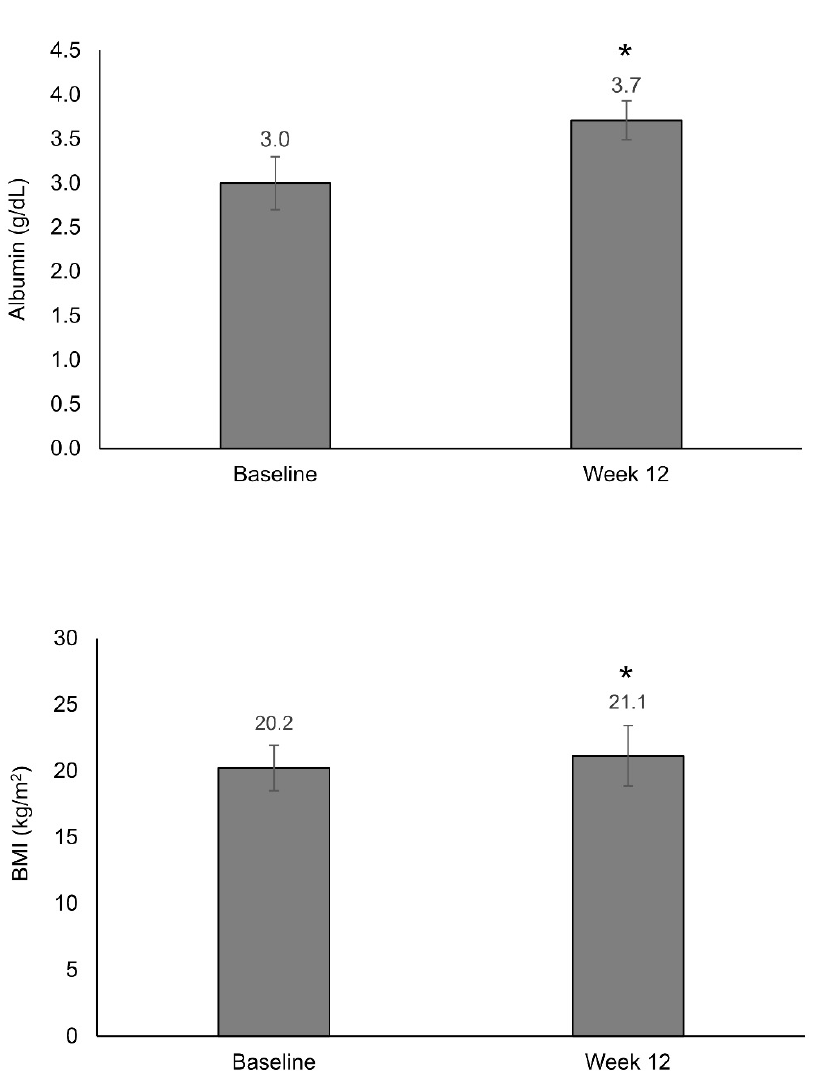
Figure 2. Change in body mass index and albumin levels after 12 weeks of treatment with a semi- elemental hydrolyzed whey protein diet. Bar graphs show mean (SD) albumin levels and body mass index (BMI) at baseline and after 12 weeks of treatment; * p < 0.001.